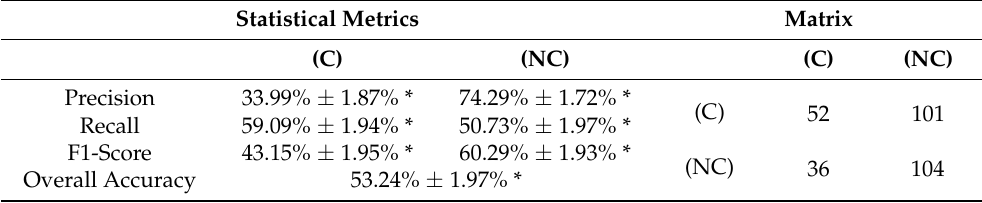
Table 2. Validation with p -value ≤